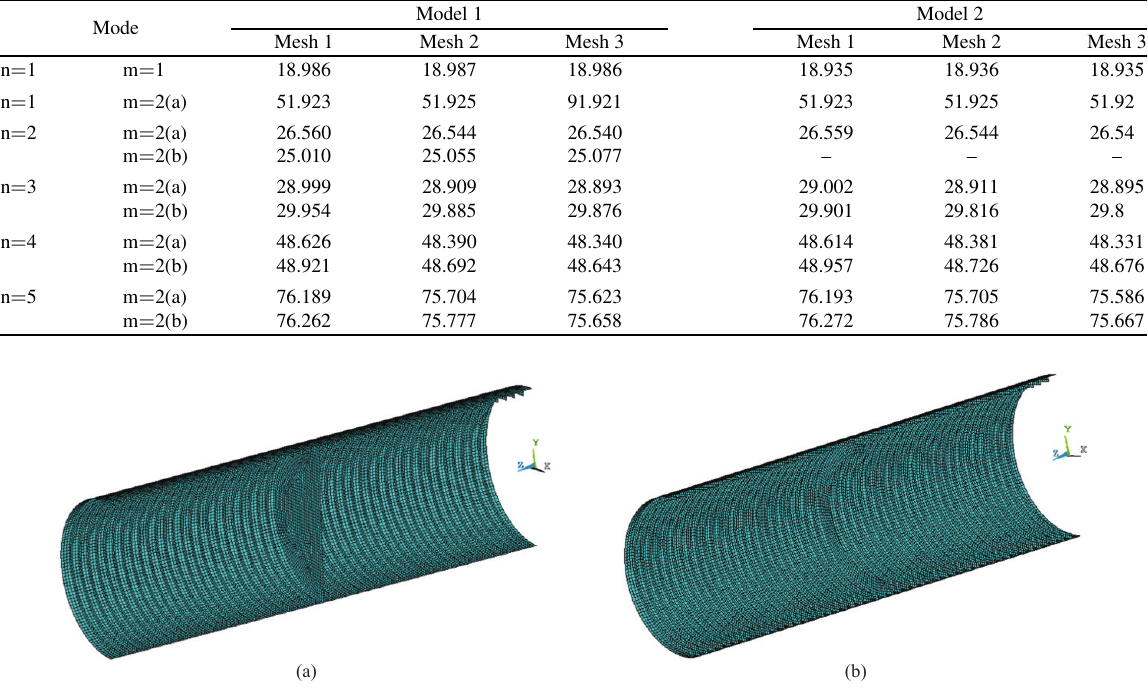
Table 3 Comparison of natural frequencies calculated by FEM with different meshes (Hz)